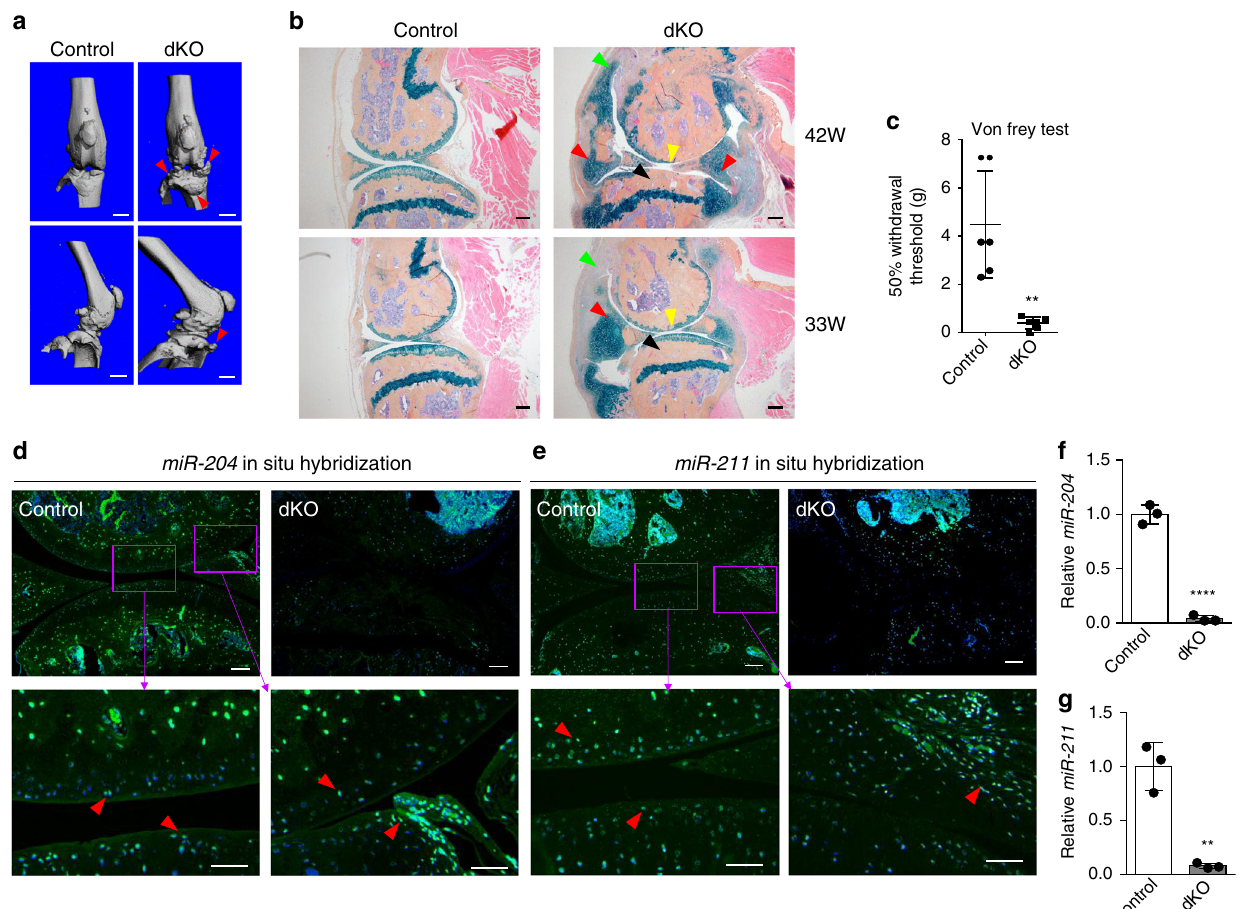
Fig. 2 De fi ciency of miR-204 /- 211 in mesenchymal progenitor cells recapitulates OA pathogenesis. a Representative μ CT images of 42-week-old miR-204 / - 211 fl oxed (control) and conditional double KO (dKO, with Prx1-Cre ) mice. Red arrowheads, osteophytes. n = 5. Scale bar, 1 mm. b Representative histology images of knee joints in 42- (top) or 33-week-old (bottom) control and dKO mice stained by Alcian blue/Orange G. Yellow arrowheads, loss of articular cartilage; red arrowheads, osteochondrophytes; green arrowheads, synovial hyperplasia; black arrowheads, subchondral sclerosis. n = 5. Scale bar, 200 μ m. c Results of von Frey test on 33-week-old control and dKO mice. n = 6. ** P < 0.01, unpaired Student ’ s t test. d , e In situ hybridization using highly speci fi c LNA-enhanced miR-204 ( d ) or miR-211 ( e ) probe (green) on knee joint sections of 7-month-old mice. The bottom panels are the enlargements of the upper images as indicated. DAPI staining marks nuclei (blue). Red arrowheads, miR-204- or miR - 211 -positive cells. Scale bar, 100 μ m. f , g qRT-PCR analysis of miR-204 and miR-211 expression in CD45 − BMSCs from control or dKO mice. ** P < 0.01, **** P < 0.0001, unpaired Student ’ s t test. n = 3. Data are shown as the mean ±